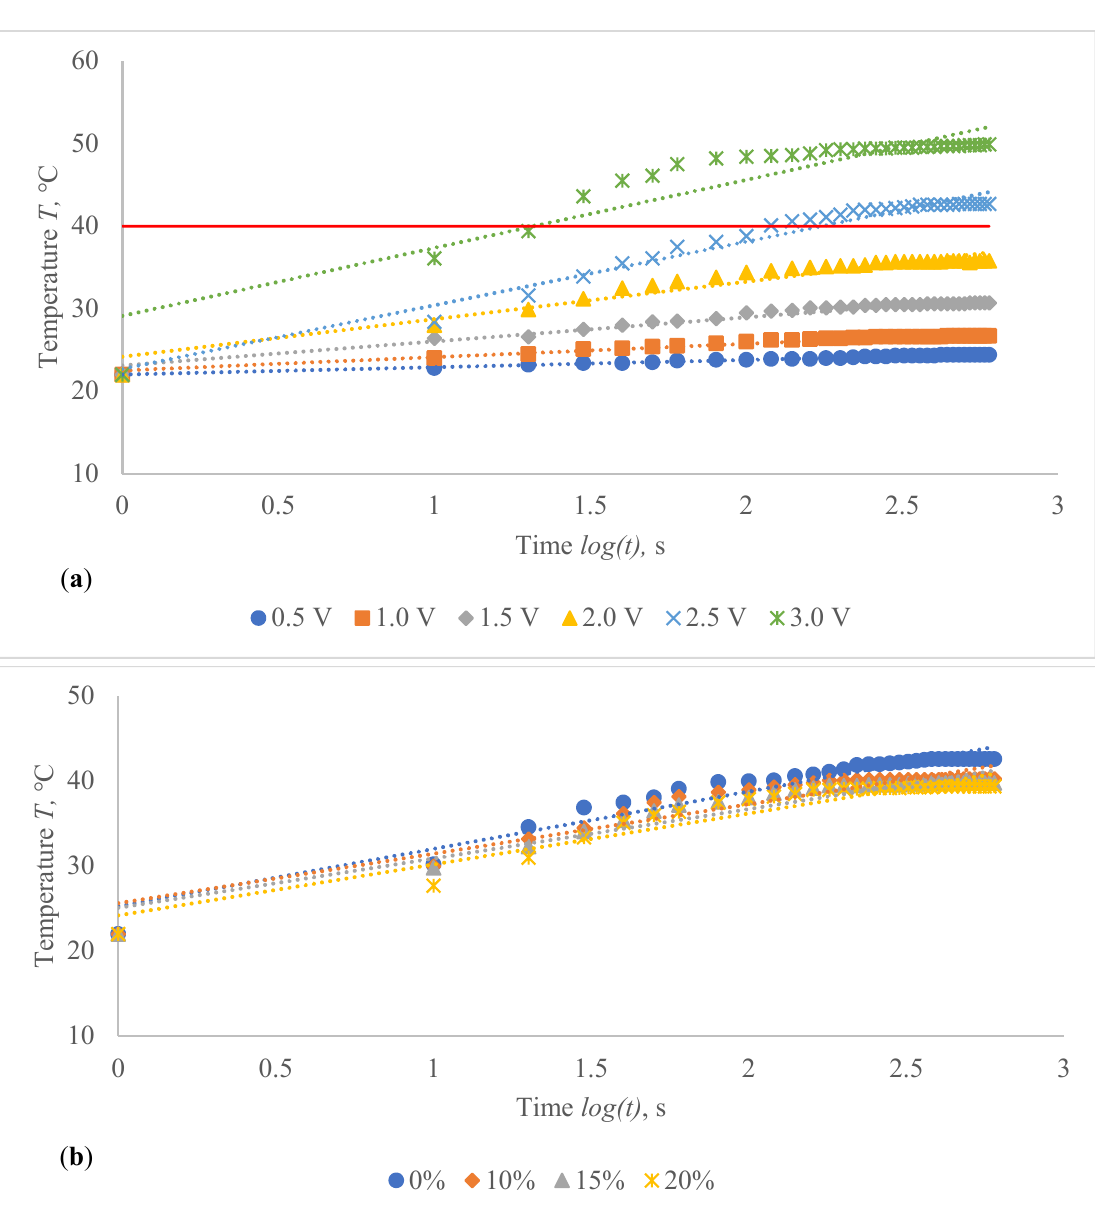
Figure 11. Temperature changes of CF_LY2 structured electro-conductive composite fabric during the 600 s period: ( a ) at non-stretched state by applying different voltage; and ( b ) at the different stretch levels by applying 2.5 V. Red line indicates the target